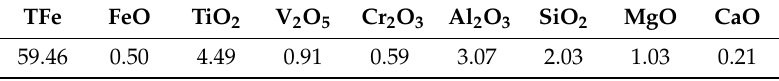
Table 2. Chemical composition of the oxidized HCVTM pellets (wt %) .